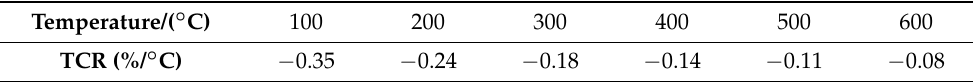
Figure 6. ( a ) Temperature control probe platform; ( b ) The variation curve of the varistors’ value with temperature. Table 3. Temperature coefficient of resistance (TCR) of p-type SiC.